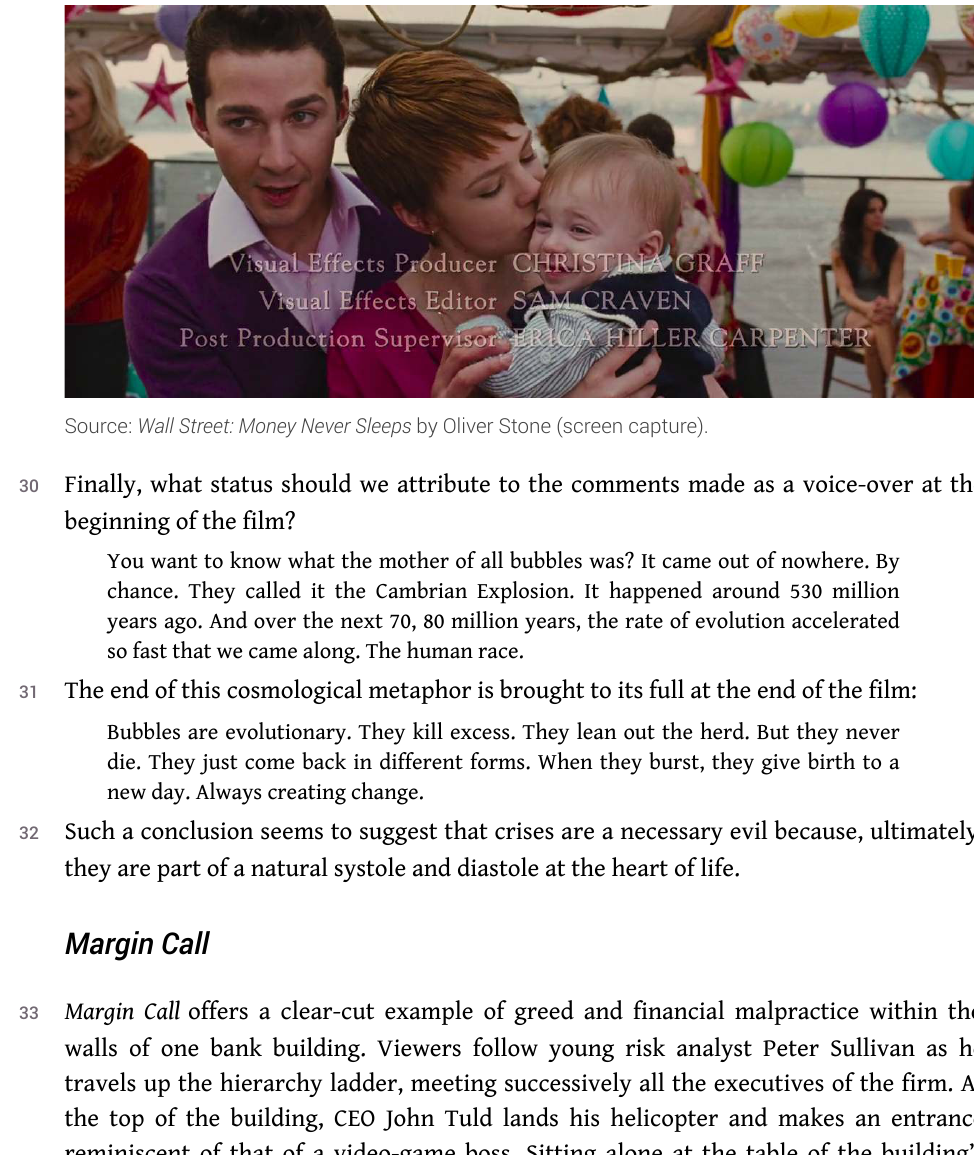
Figure 1: A family crisis with a happy ending (Shia LaBeouf and Carey Mulligan) in Wall Street: Money Never Sleeps by Oliver Stone.